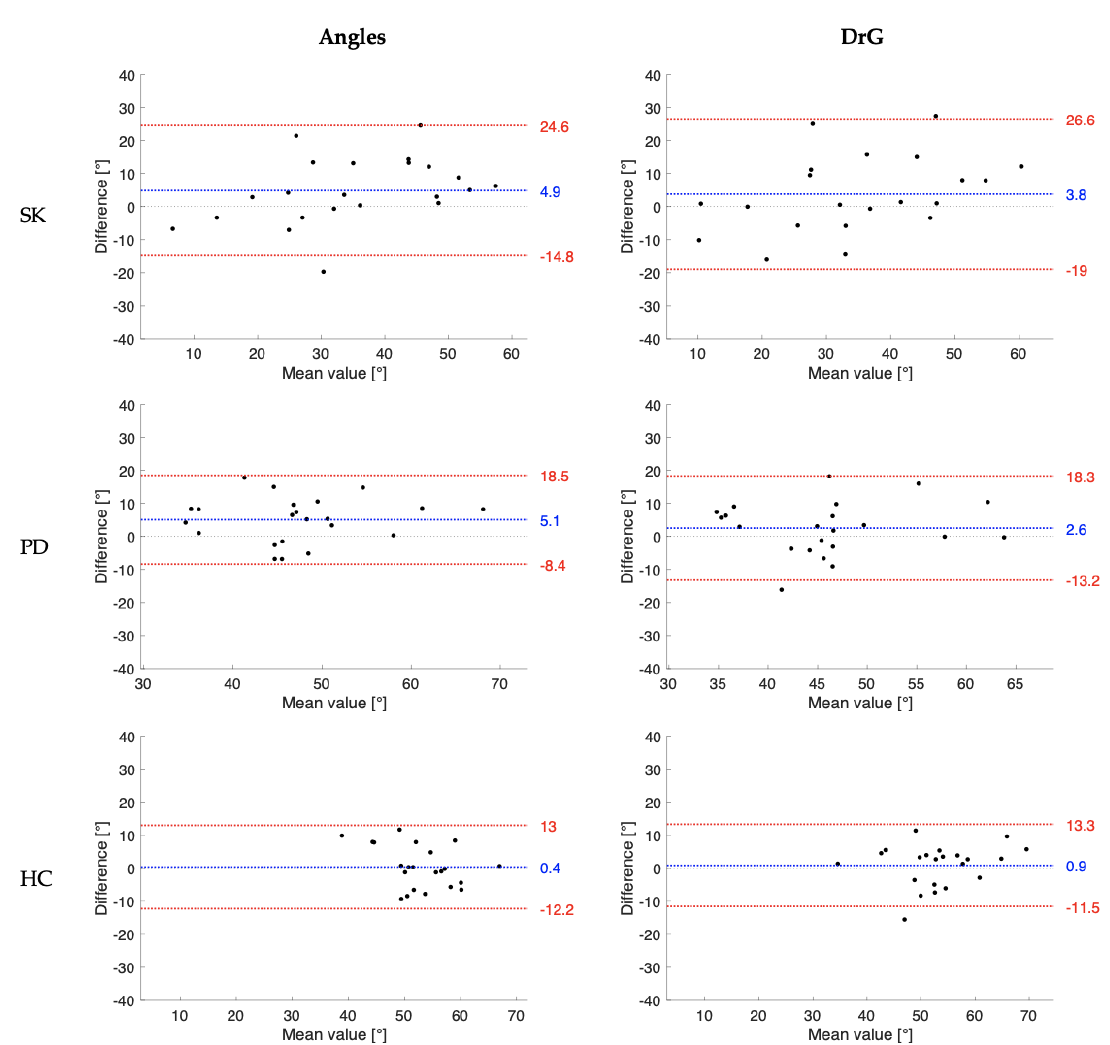
Figure 3. Bland-Altman plot of the knee range of motion of the three participant populations (SK: post-stroke patients, PD: patients with Parkinson’s disease, HC: healthy controls) collected by the inexperienced examiner (I1) using the Angles and DrGoniometer applications. The blue line indicates the mean differences between the mobile app and electro-goniometer measures, and the red lines are the 95% lower and upper limits of agreement.